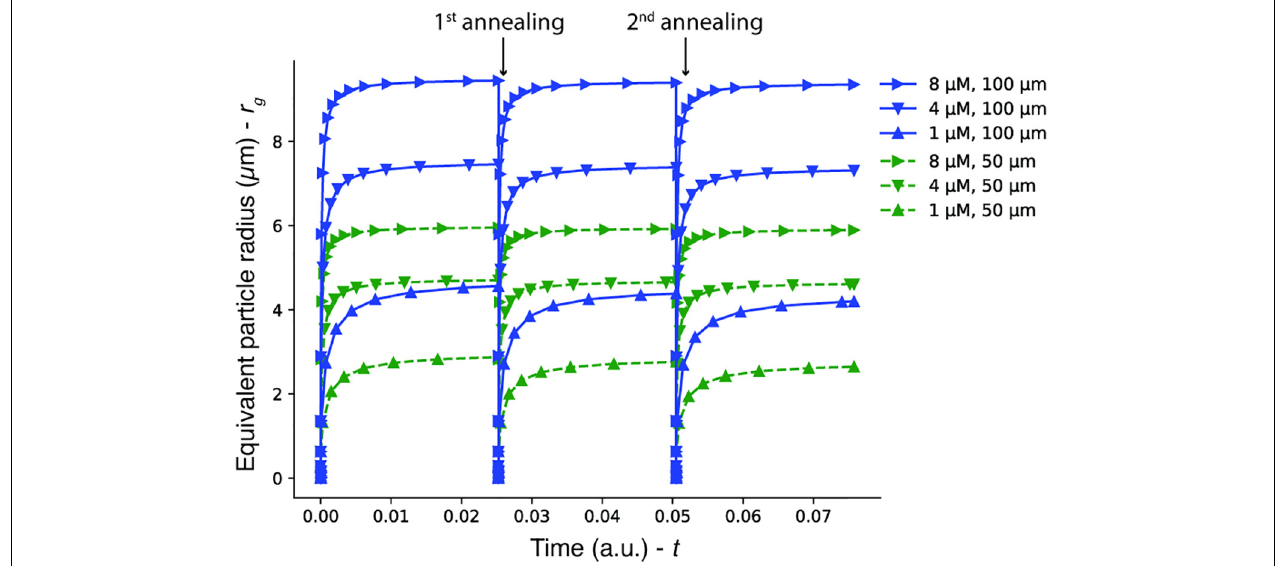
FIGURE 6 | Model of DNA aggregate growth according to initial DNA concentration and microwell